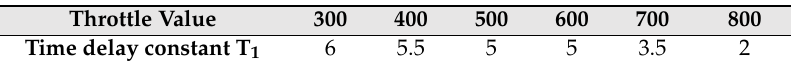
Table 1. Selection of T 1 for each throttle